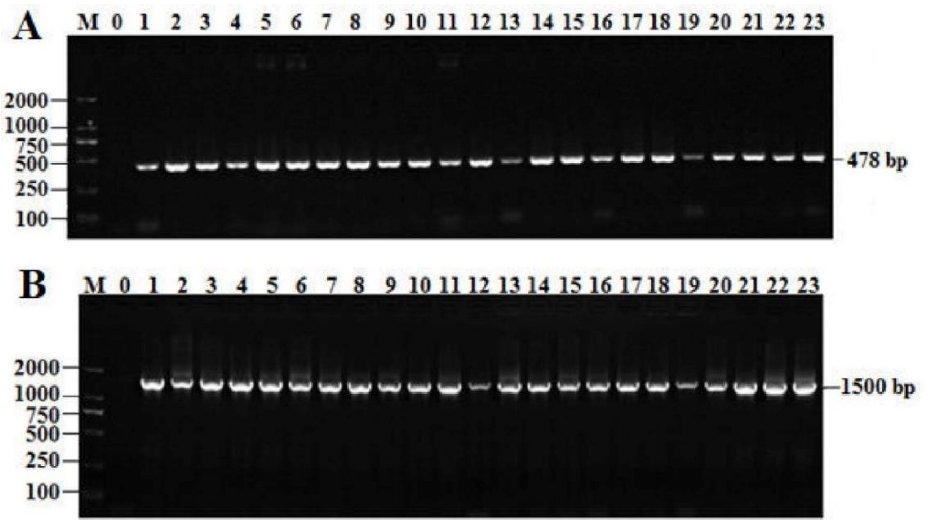
Figure 2. The PCR (polymerase chain reaction) results of the screened T. halophilus strains. ( A ) The screened T. halophilus strains by amplification of groEL gene; Lane M: DNA Marker DL2000; Lane 0: negative; Lane 1–23: Candidate strain of T. halophilus; ( B ) Electrophoresis of amplification product; Lane M: DNA Maker; Lane 0: Negative control; Lanes 1–23: The band of PCR amplification products of DNA primer PCR.